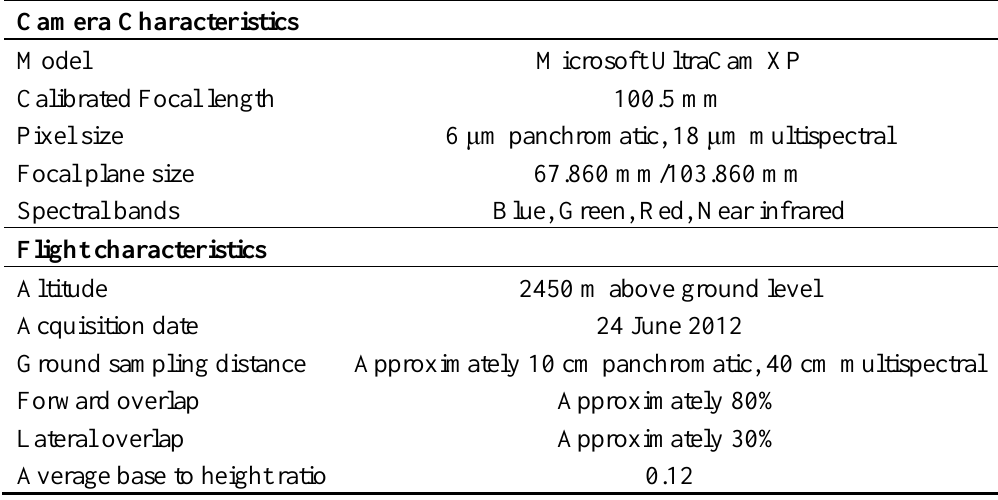
Table 2. Camera and flight characteristics of the aerial